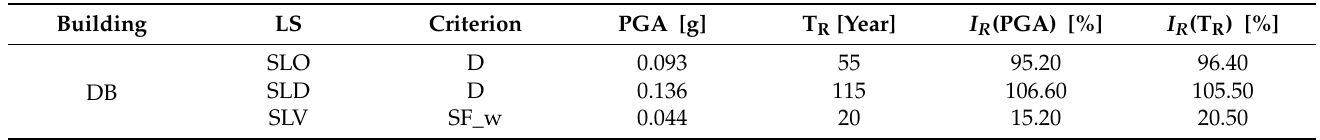
Table 1. Seismic performance indices for the DB